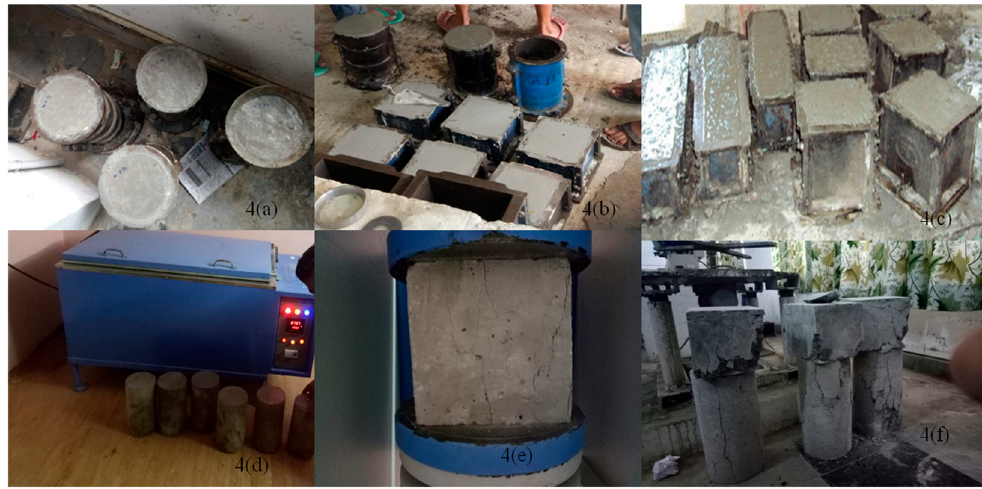
Figure 4. (a) Geopolymer concrete cylindrical specimens casting, (b) casting of cube specimens, (c) cube and cylindrical specimens, (d) cylindrical specimens for oven curing, (e) testing of cube for compressive strength, (f) Failure of specimens after